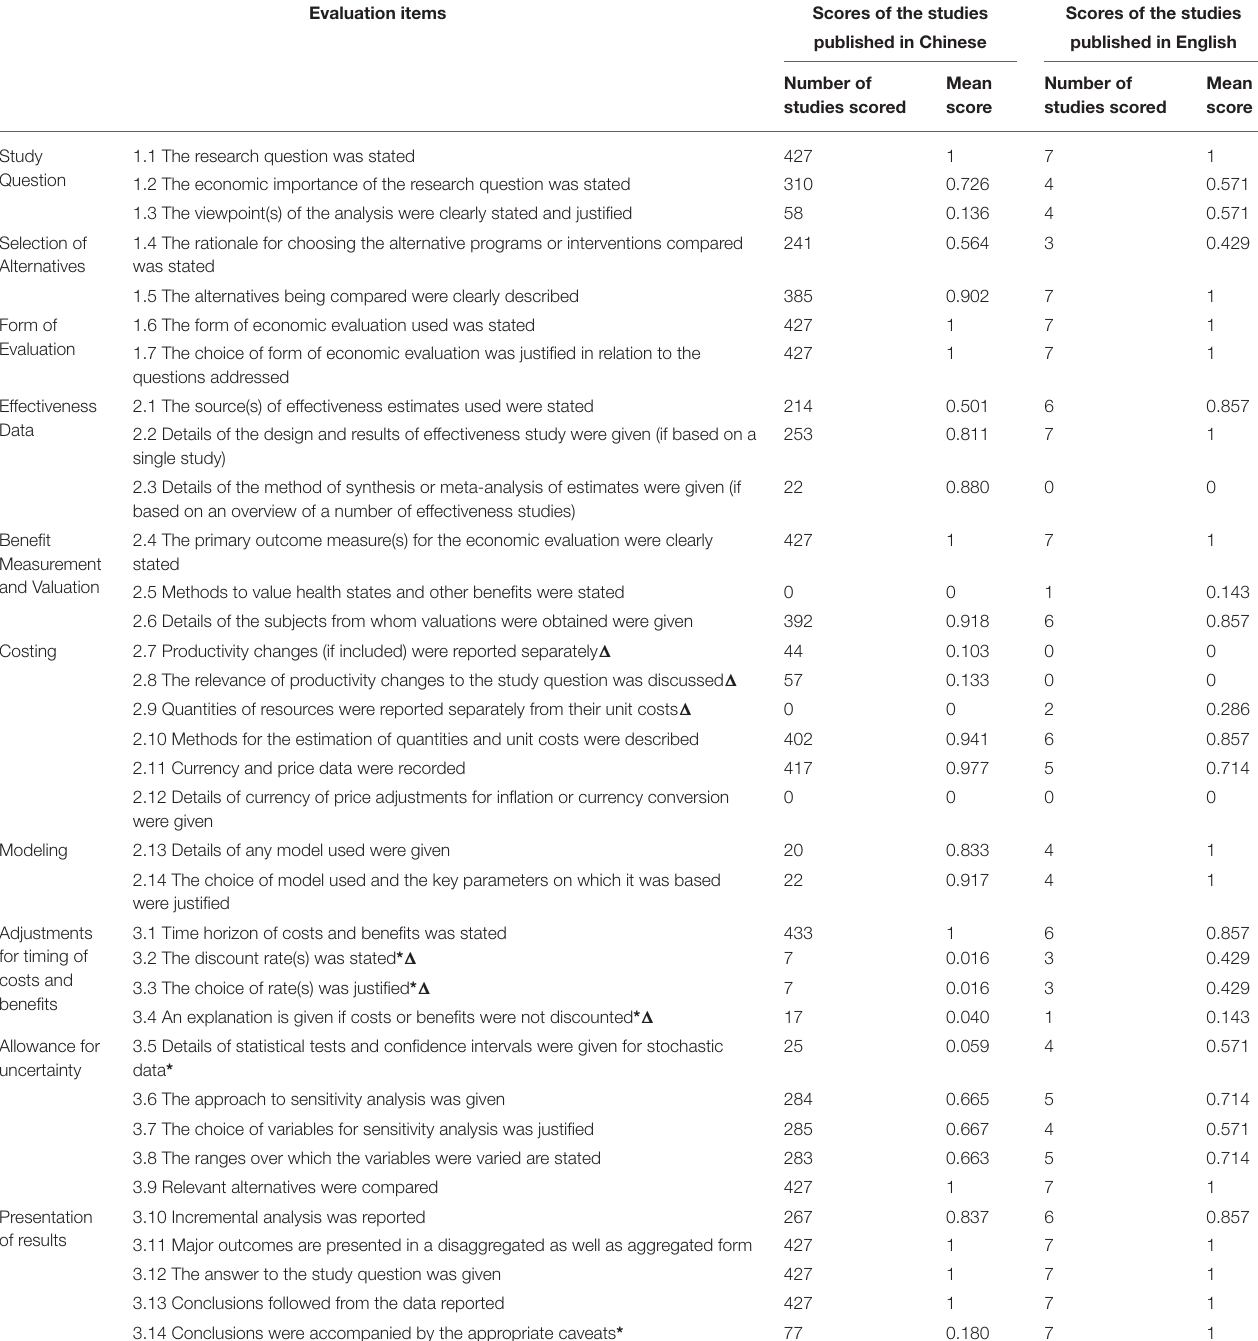
TABLE 4 | Quality Evaluation Scoring of Included Pharmacoeconomic Studies on TCM (N =